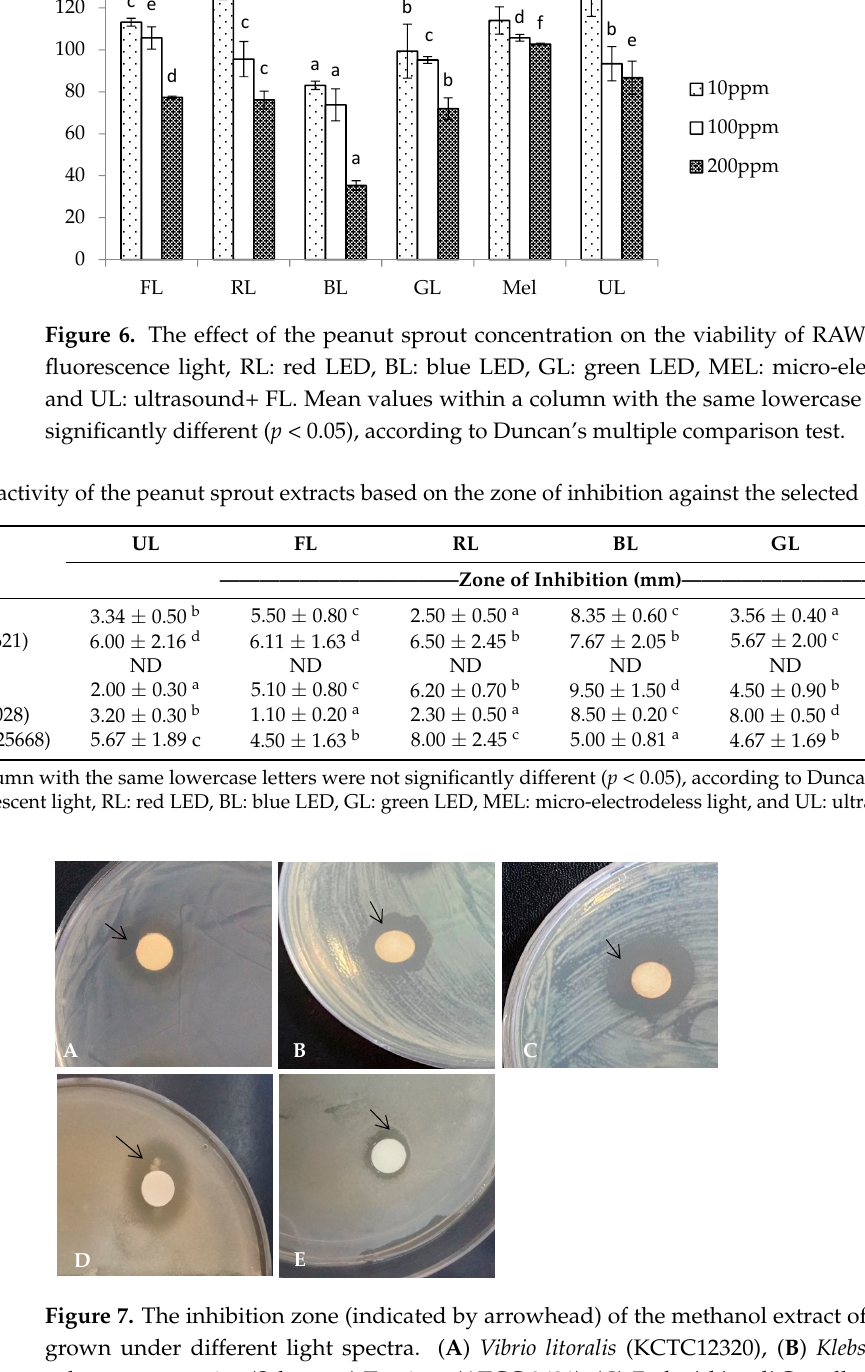
Figure 8. Inverted microscopy-based images of cells. ( A ) E. coli Castellani and Chalmers (ATCC35150) ( i ) without treat- ment, ( ii ) treatment with peanut sprouts grown under blue LED, and ( iii ) treatment with peanut sprouts grown under FL light. ( B ) S. enteritidis serotype typhimurium Kauffmann and Edwards (ATCC14028) ( i ) without treatment, ( ii ) treatment with peanut sprouts grown under blue LED, and ( iii ) treatment with peanut sprouts grown under FL light. The LIVE/DEAD™ BacLight™ Bacterial Viability analysis showed the live cells in green and dead cells in red.